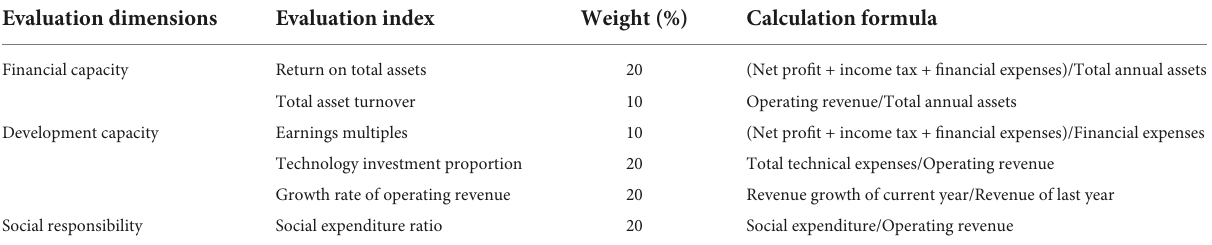
TABLE 3 Enterprise performance evaluation